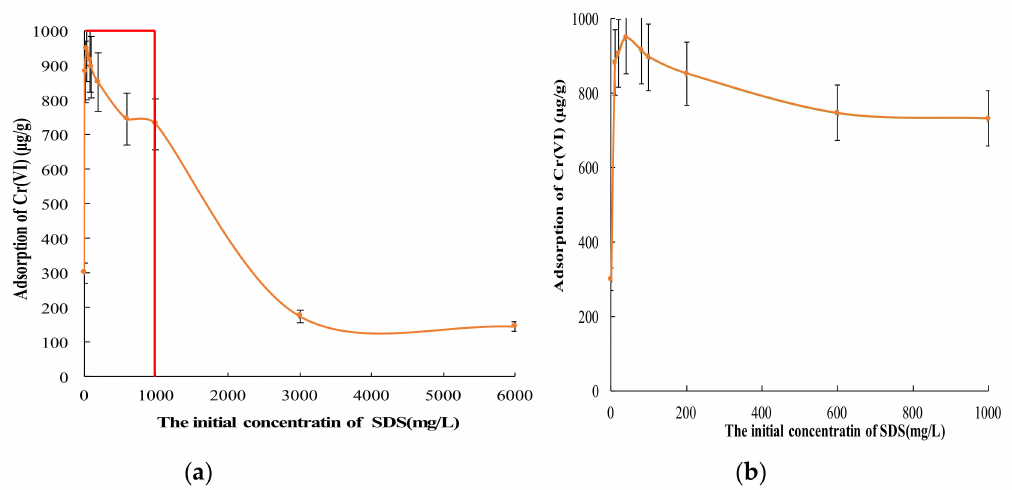
Figure 2. Adsorption of Cr(VI) for di ff erent initial SDS concentrations (10–6000 mg / L). ( a ) E ff ect of initial SDS concentrations (10–6000 mg / L) on the adsorption of chromium (Cr) (VI). ( b ) E ff ect of initial SDS concentrations (10–1000 mg / L) on the adsorption of